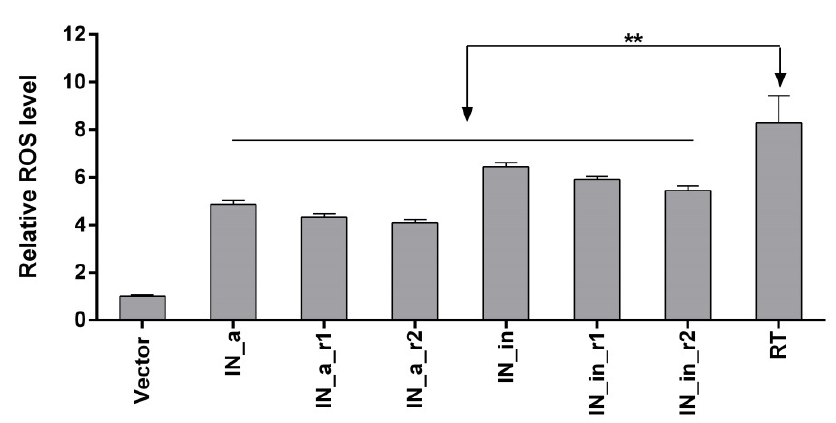
Figure 4. Transient expression of IN in eukaryotic cells induces moderate levels of ROS. HEK293T cells were transfected with pVax1-based plasmids expressing IN_a, IN_a_r1, IN_a_r2, IN_in, IN_in_r1, and IN_in_r2 or HIV-1 reverse transcriptase of clade B (HXB2) [15,72]. Production of ROS was detected using sensor dye 2 (cid:48) ,7 (cid:48) -dichlorodihydrofluorescein diacetate (DCFH-DA). The level of flu- orescence emitted by reaction products of DCFH-DA and ROS in IN and RT expressing cells were normalized to those in the cells transfected with empty vector pVax1. Data represent the results of two independent experiments, each done in triplicate, mean +SD. Results are compared using Kruskal–Wallis and Mann–Whitney tests; difference between different IN variants, p > 0.1; difference between IN variants and HIV-1 RT, **— p < 0.01 (Kruskal–Wallis, Mann–Whitney